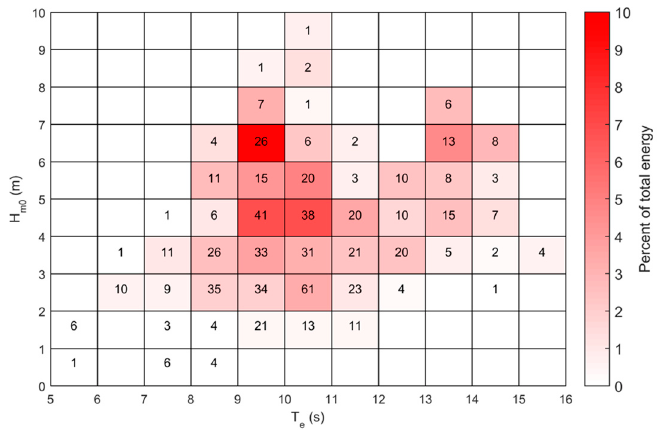
Figure 7. Bivariate distribution of occurrence and energy showing the probability and energy distribution defined by significant wave height and energy period. The results are calculated from the field data at NDBC 46050 in 2009.